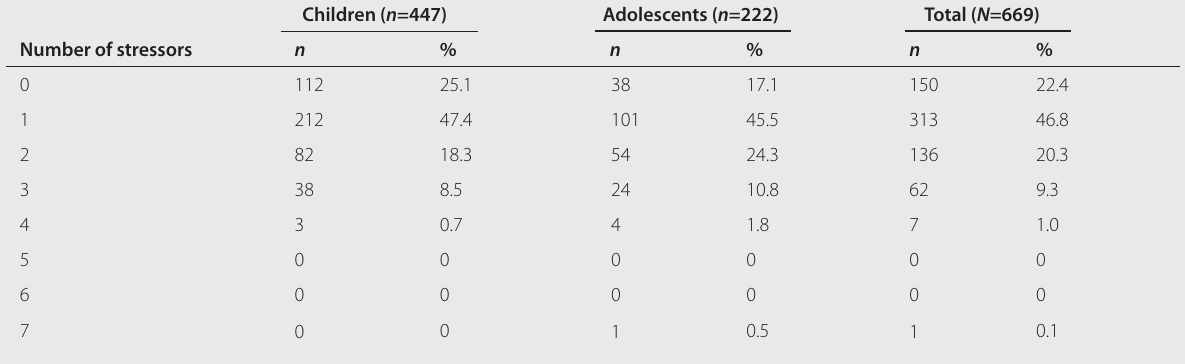
Table 5. Number of stressors identified in children and adolescents seen at the Child and Adolescent Unit of the FSPC from January 2006 to December